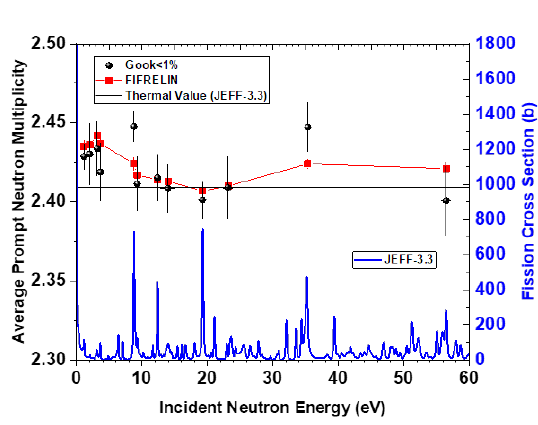
Figure 4. Same as in Fig. 3, but for the 12 more accurate reso- nances (statistical uncertainties lower than